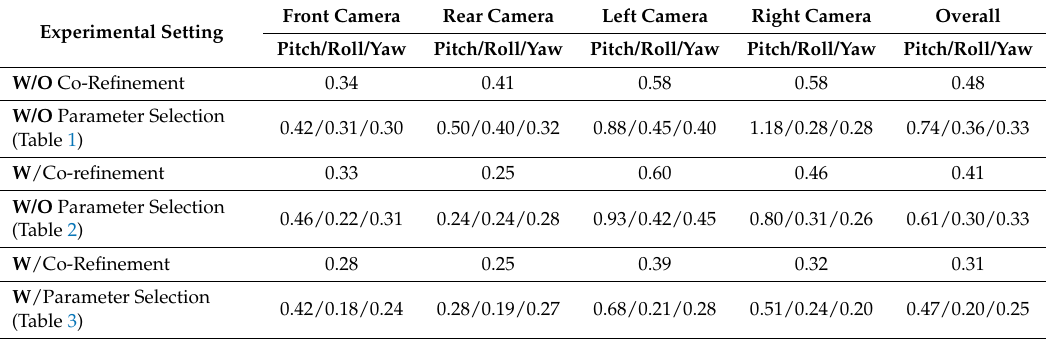
Table 4. Quantitative Performance Comparison with Different Experimental Settings